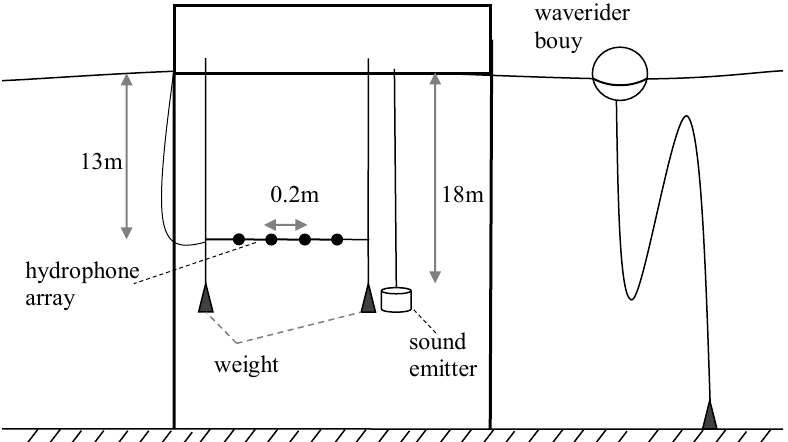
Figure 3. Experiment scheme in the vertical